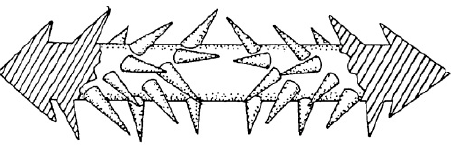
Figure 5. Dr. Gregory Ruff’s conical barb design of a tissue connector [20].